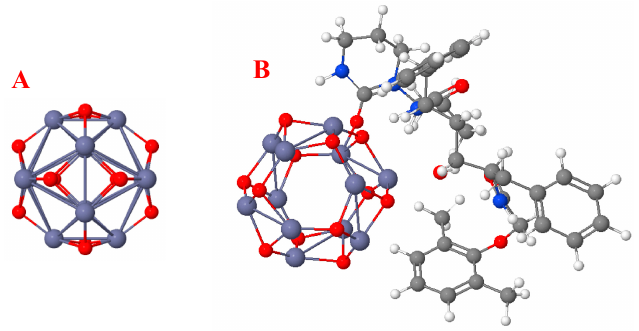
Figure 4. Optimized structures of the ( A ) (ZnO) 12 ‐ NP, and the ( B ) (ZnO) 12 ‐ Lop.